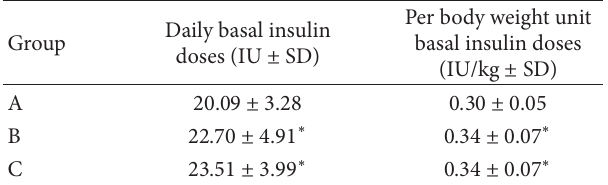
Table 3: Comparison of basal insulin doses upon achievement of good blood glucose